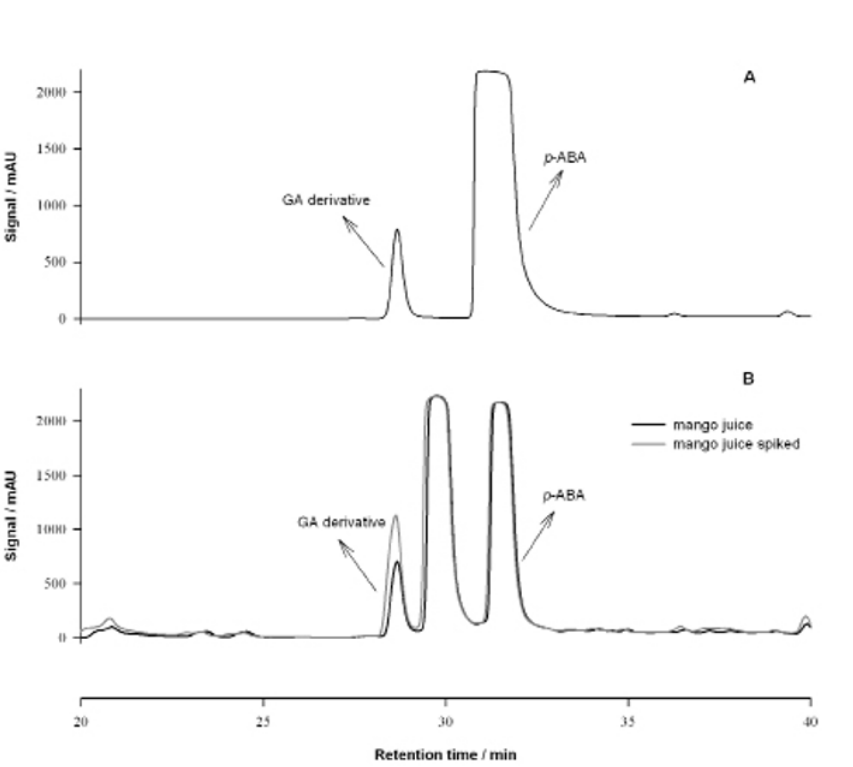
Figure 2. Chromatograms obtained in the HPLC-DAD analysis for a GA standard solution (A) and for a commercial mango juice without and with 16.5 mg L -1 of GA standard (B). The HPLC analysis was carried out as described in the Experimental section. Table 3. Galacturonic acid conten t (mg L -1 ) in several commercial fruit juices (n = 3) Fruit